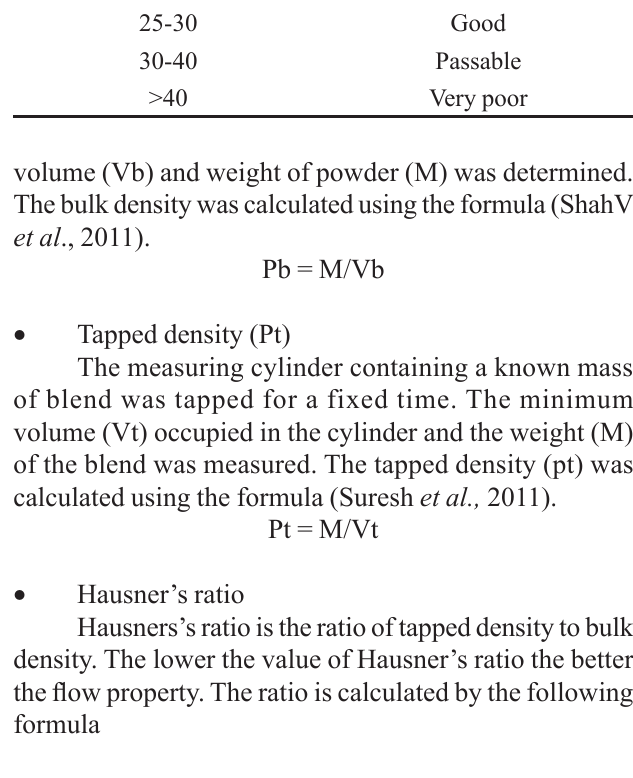
TABLE II - Relationship between angle of repose ( q ) and flow properties Angle of repose ( q ) (degrees)